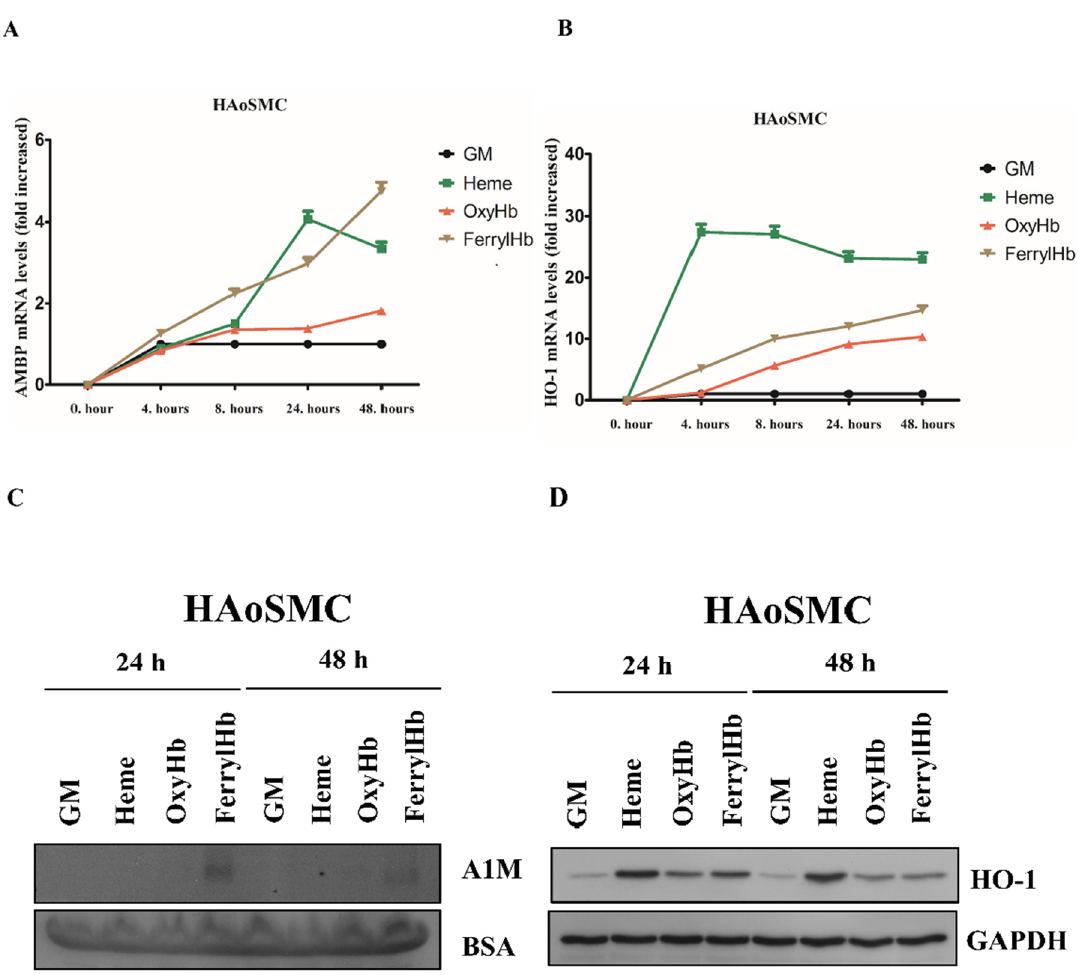
Figure 3. A1M expression is induced in human aortic smooth muscle cells (HAoSMCs). HAoSMCs were exposed to heme (10 µM), OxyHb (10 µM), or FerrylHb (10 µM) in the presence of 5% foetal calf serum. A1M ( A ) and HO-1 ( B ) mRNA expression was quantified by qPCR after 4, 8, 24 and 48 h. ( C ) Secreted A1M protein was detected by immunoblotting